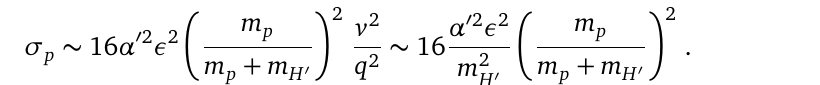
Figure 6: Constraints on R − 1 versus m model with Stückelberg mixing and fraction f constituents, from Ref. [ 37 ] . The parameter δ is defined to be δ = ε − λ